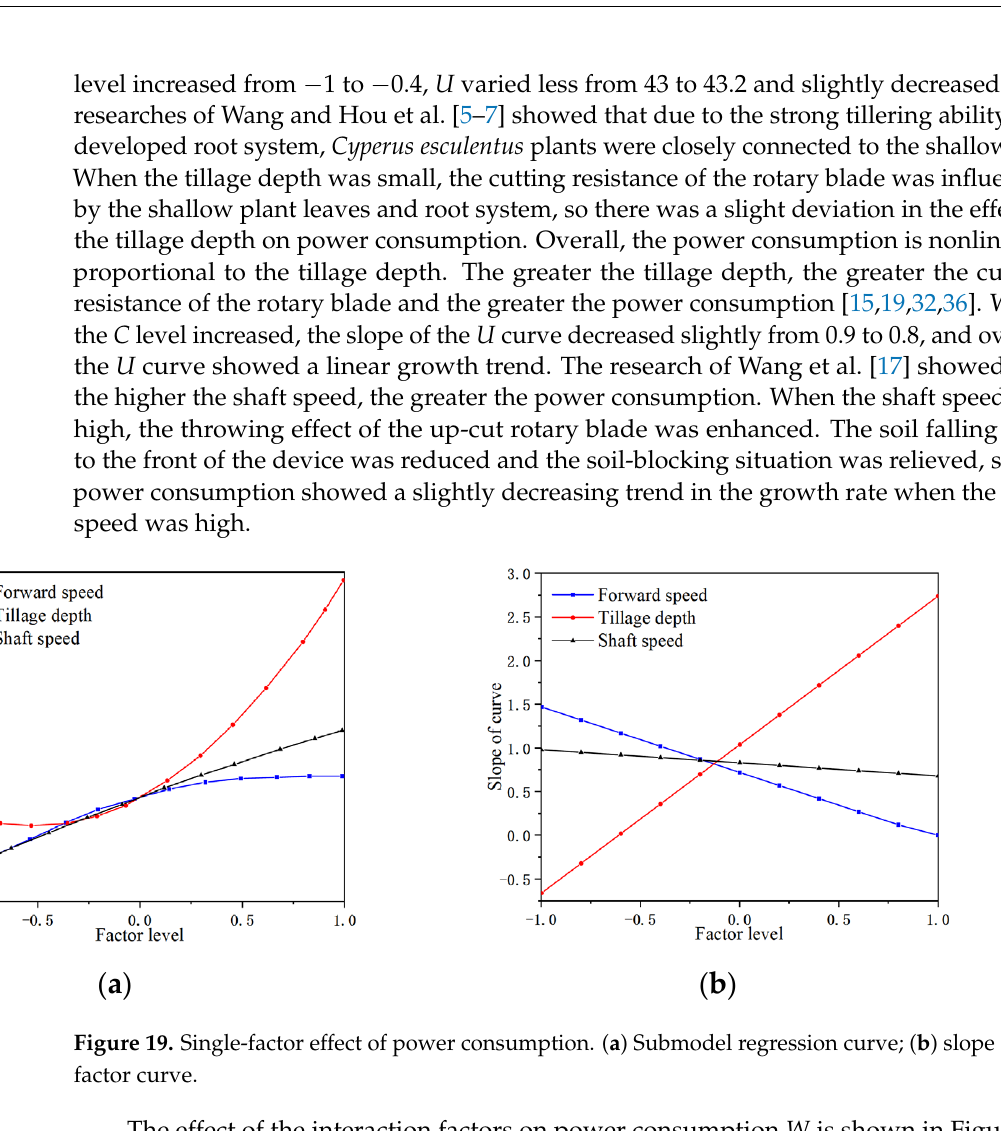
Figure 19. Single-factor effect of power consumption. ( a ) Submodel regression curve; ( b ) slope of the factor curve.